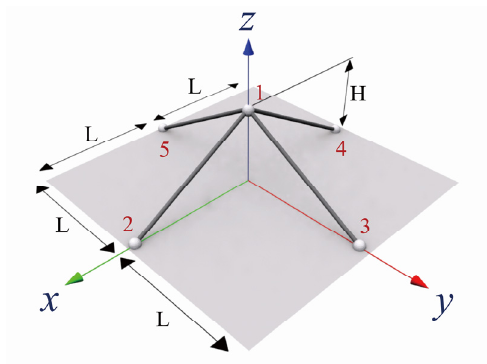
Figure 1. Shape of single-free-node (SFN) model.